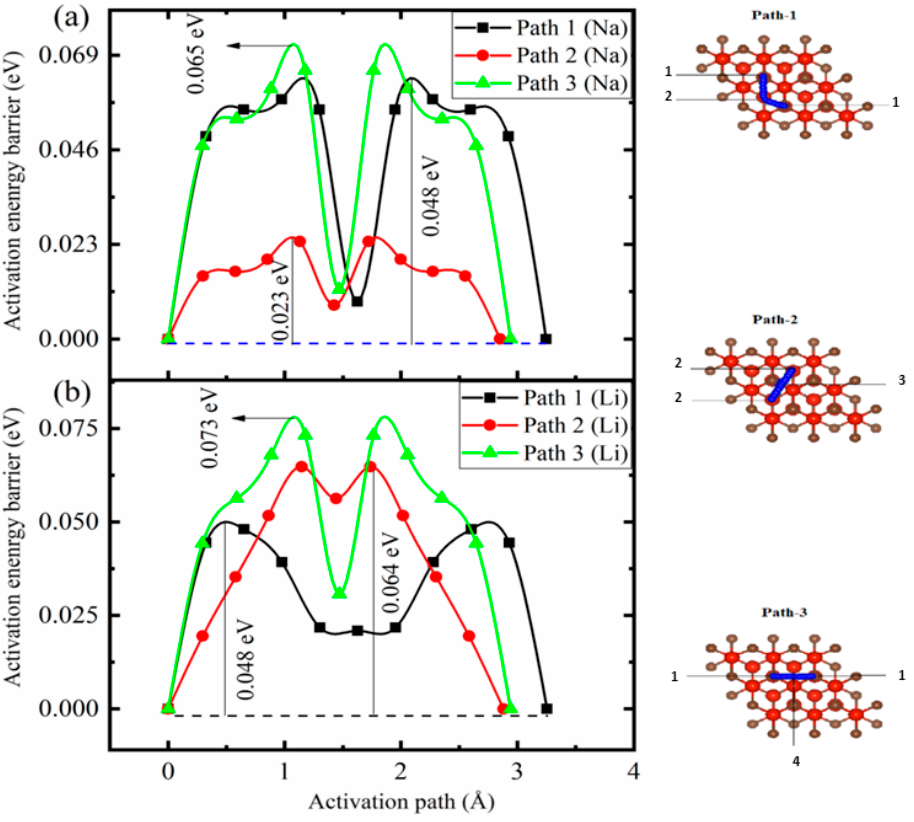
Figure 5. Activation pathways with their corresponding energy barriers of Na ( a ) and Li ( b ). The numbers (1-2-1, 2-3-2, and 1-4-1) represent the energy paths for the migration of Li/Na content ( x = 0.0625) Table 2. Comparison of voltages and energy barriers with Li x V 4 C 3 and Na x V 4 C 3. Material